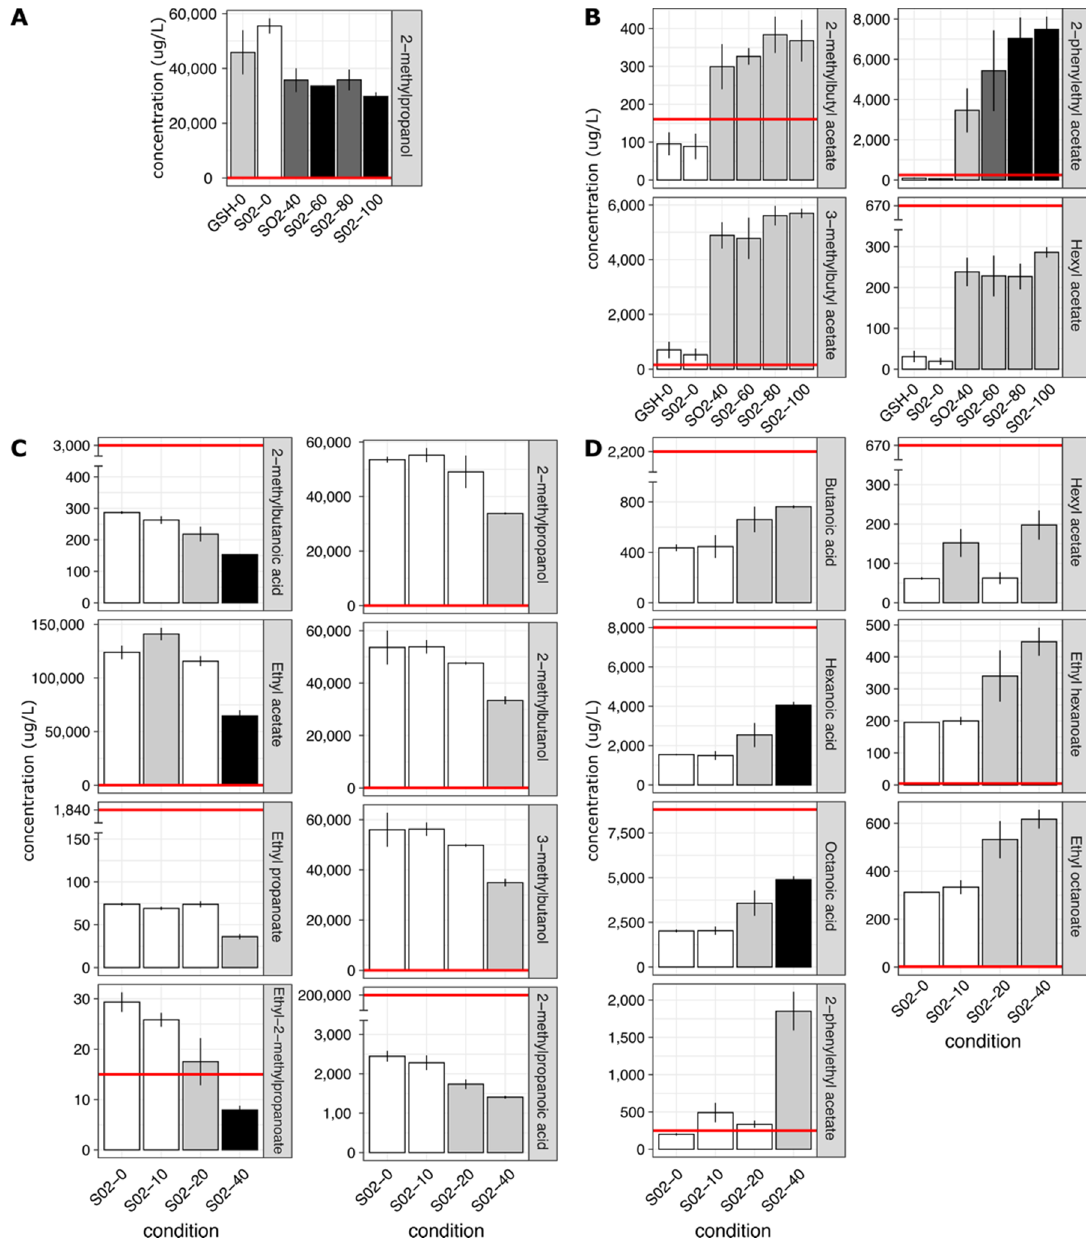
Figure 6. Concentration di ff erences in aroma compounds due to the addition of SO 2 . ( A ) Analytes with significantly reduced (ANOVA, p ≤ 0.001) concentrations in 2018. ( B ) Analytes with significantly increased (ANOVA, p ≤ 0.001) concentrations in 2018. ( C ) Analytes with significantly decreased (ANOVA, p ≤ 0.001) concentrations in 2019. ( D ) Analytes with significantly increased (ANOVA, p ≤ 0.001) concentrations in 2019. Individual bars are shaded according to their significance group and the estimated aroma thresholds (see Materials and Methods) are indicated in